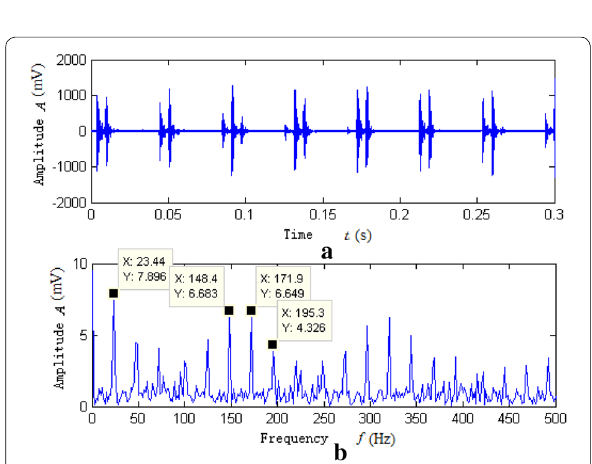
Figure 21 High frequency component of N205 with the severe defect on the inner race: ( a ) time waveform, ( b ) local spectrum